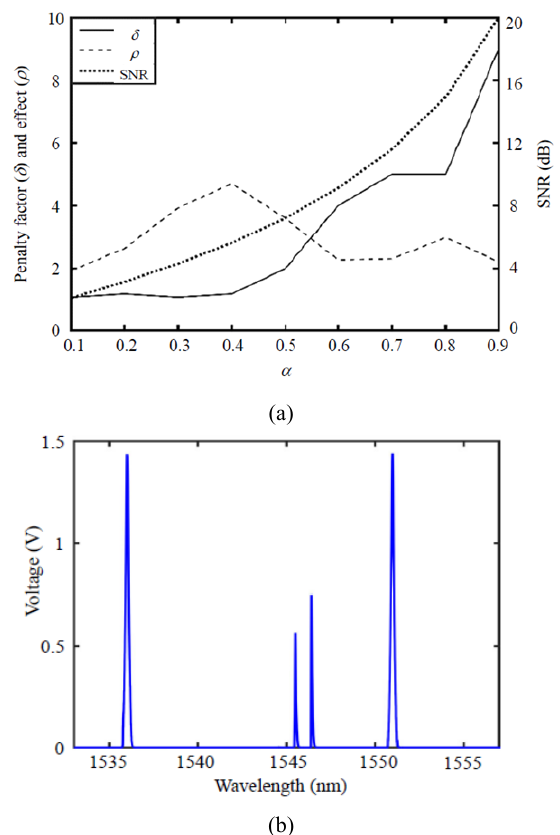
Fig. 8 Choose of  and the effect of the first-order lag filter: (a)  , SNR, and hysteresis effects change with  and (b) the effect of the first-order lag filter when  is fixed at